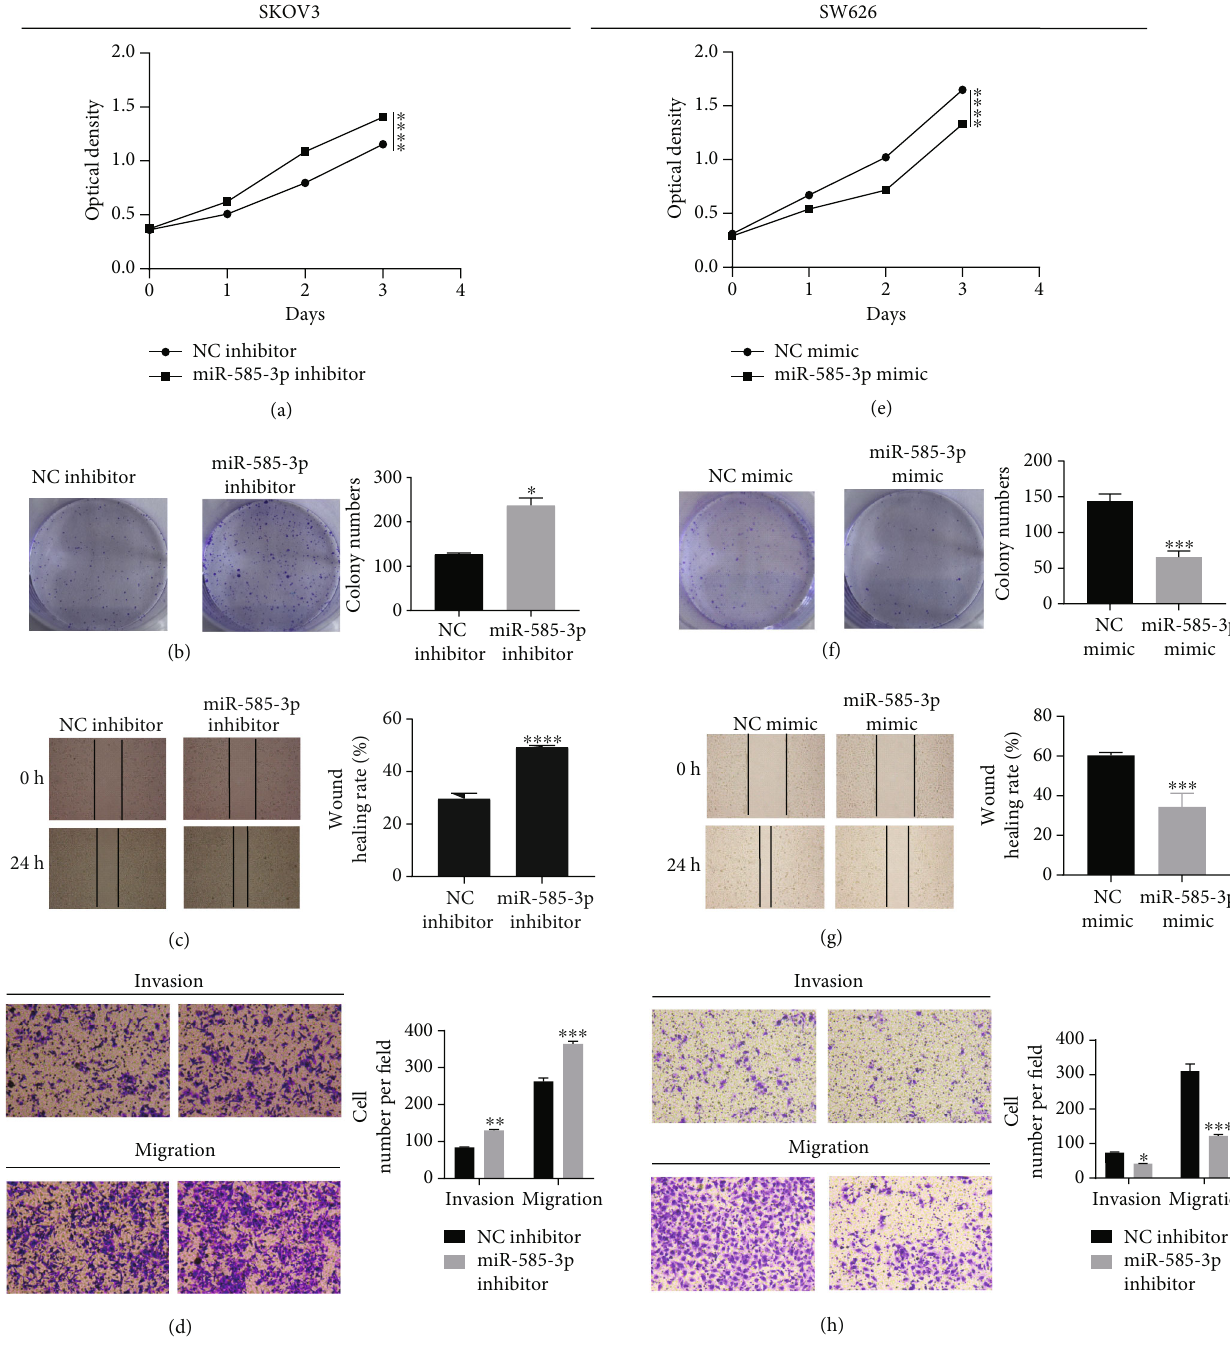
Figure 2: Overexpression of miR-585-3p inhibits the proliferation, migration, and invasion of OC cells. (a) CCK-8 detects the OD value of SKOV3 cells transfected with miR-585-3p inhibitor. (b) The cell clone assays detect the number of cell clones of SKOV3 cells transfected with miR-585-3p inhibitor. (c) Scratch wound healing assays detect the scratch distance after SKOV3 cells are transfected with miR-585- 3p inhibitor. (d) Transwell assays detect the number of cell migration and invasion of SKOV3 cells after transfection of miR-585-3p inhibitor. (e) CCK-8 detects the OD value of SW626 cells transfected with miR-585-3p mimic. (f) The cell clone assays detect the number of cell clones of SW626 cells transfected with miR-585-3p mimic. (g) Scratch wound healing test detects the scratch distance after SW626 cells are transfected with miR-585-3p mimic. (h) Transwell assays detect the number of cell migration and invasion of SW626 cells after transfection of miR-585-3p mimic. ∗ P < 0 : 05 , ∗∗ P < 0 : 01 , ∗∗∗ P < 0 : 001 , and ∗∗∗∗ P < 0 : 0001